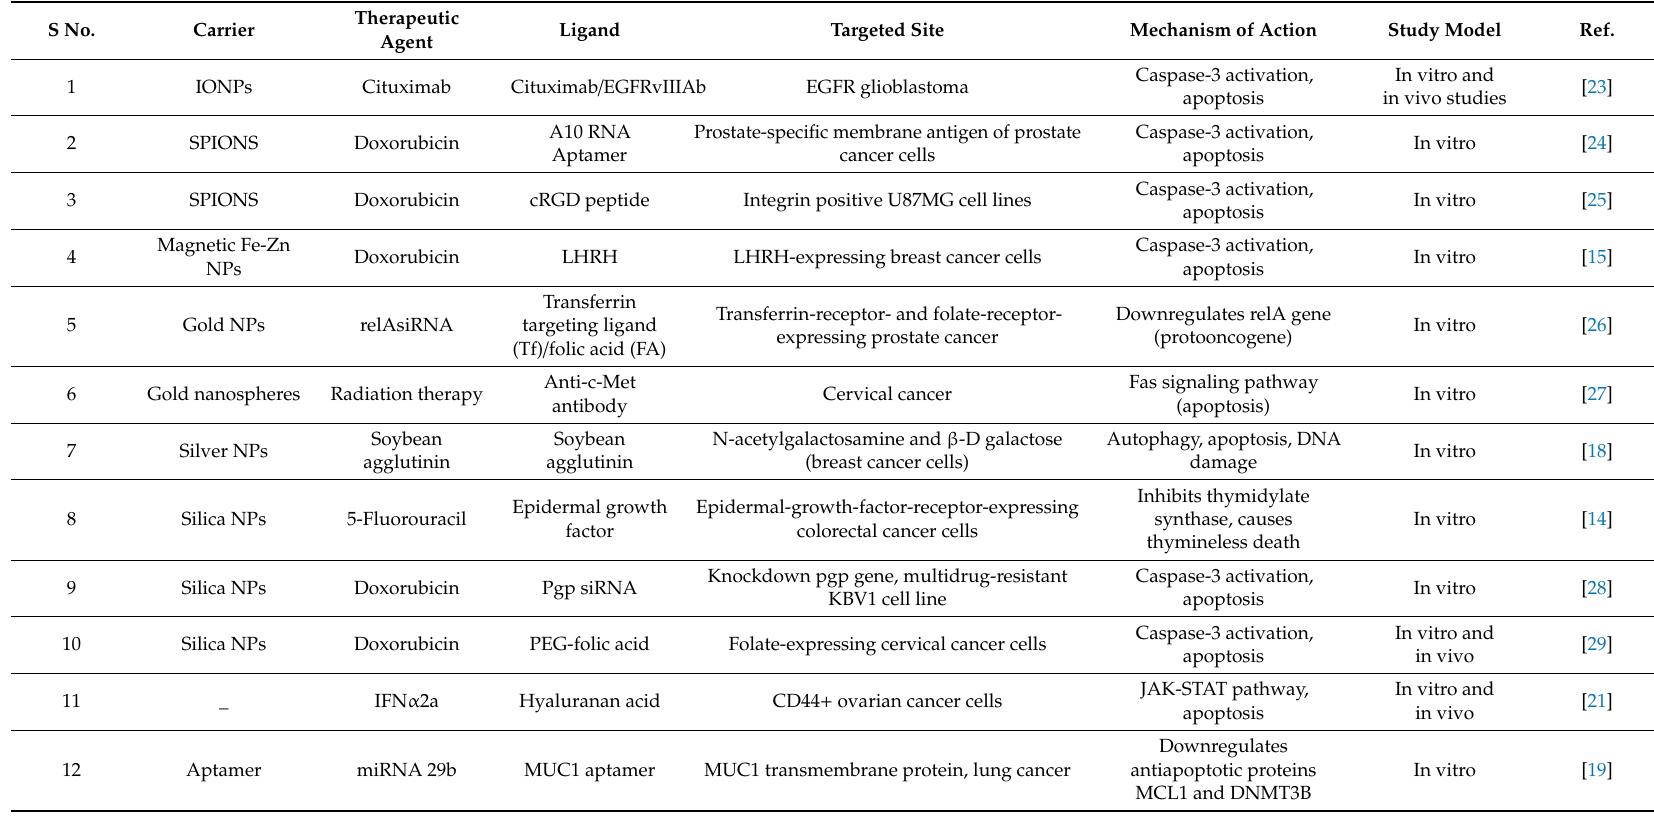
Table 1. Some examples of di ff erent bioconjugates developed so far. (IONPs: Iron oxide nanoparticles, EGFR: Epidermal growth factor receptor, cRGD: cyclic arginine-glycine-aspartate motif, LHRH: Luteinizing hormone-releasing hormone, HER2: human epidermal growth factor receptor 2, 7 \ NPs: nanoparticles, QD: quantum dots, MDR: multidrug resistance, MUC1: mucin 1, Pgp: P-glycoprotein, PLGA: poly lactic-co-glycolic acid, TPGS: tocopheryl polyethylene glycol succinate, HA: Hyaluronic